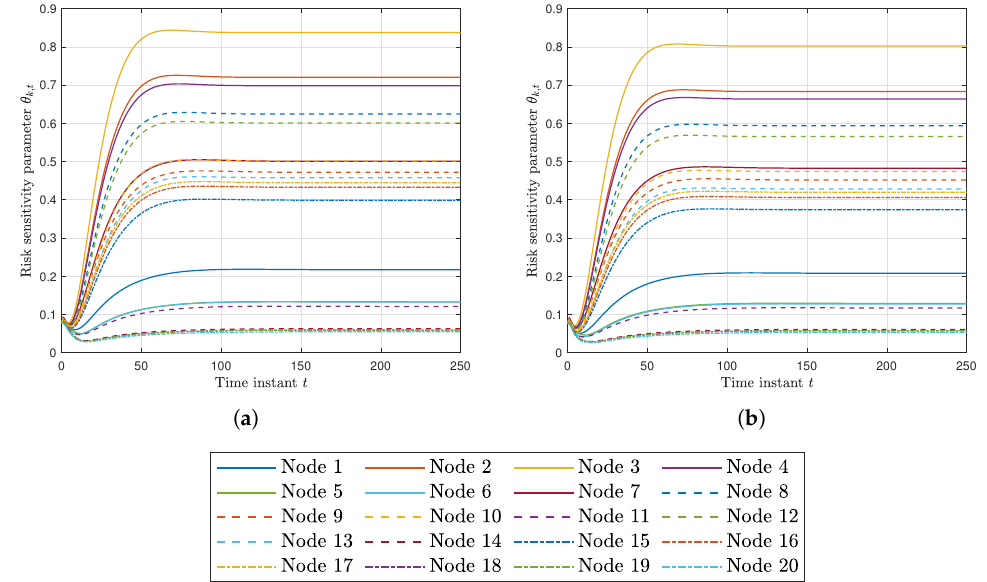
Figure 4. ( a ) Risk sensitivity parameter for each node using RKFDU with tolerance c = 0.02. ( b ) Risk sensitivity parameter for each node using RKFDNU with tolerance c =